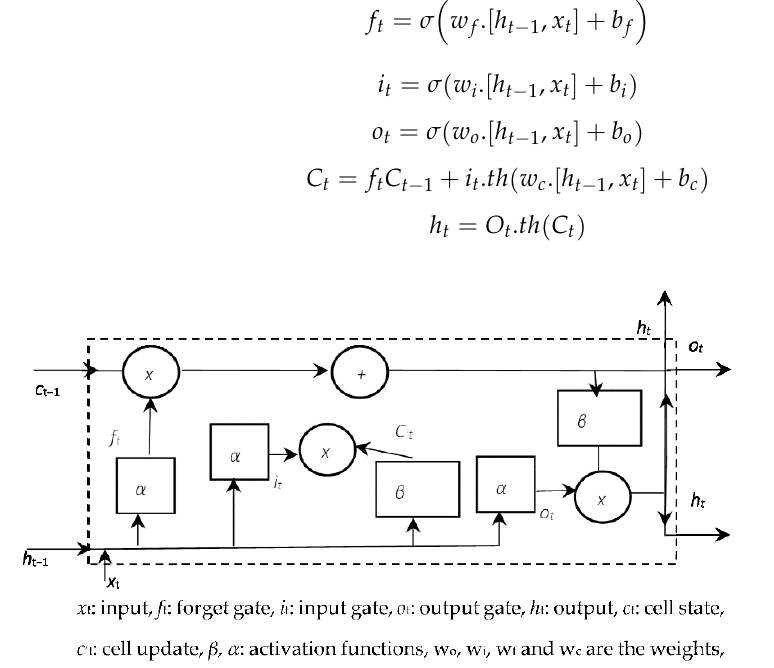
Figure 2. Basic structure of an LSTM.